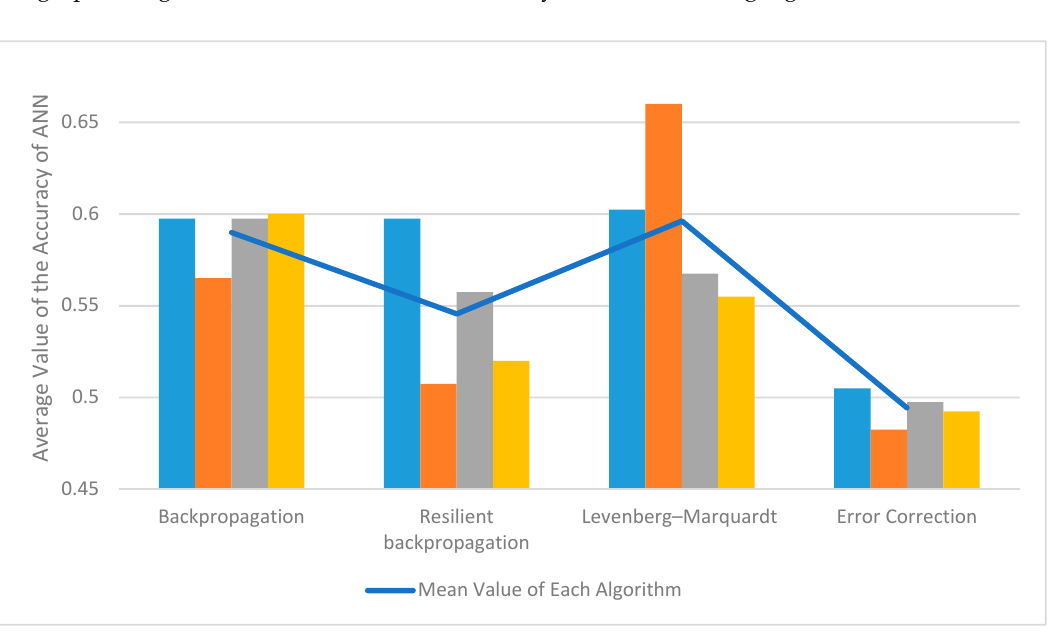
Figure 11. The average value of the accuracy of machine learning algorithms taking into account only four experiments in each series. Blue—subject 1, orange—subject 2, gray—subject 3, yellow—subject 4.